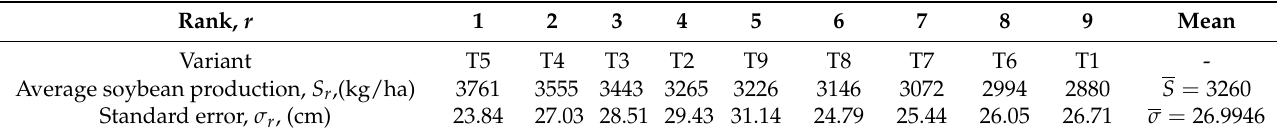
Table 3. Values for the average soybean crop production, in descending order.